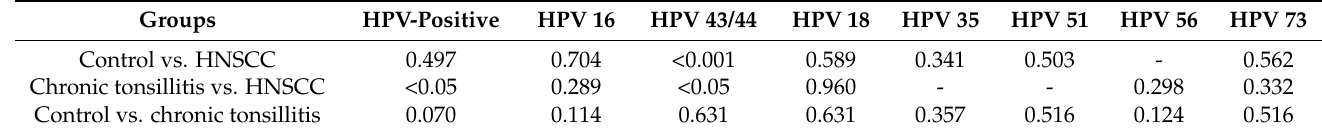
Table 3. Statistical significance calculated with the proportion test of the HPV-positive results between groups.